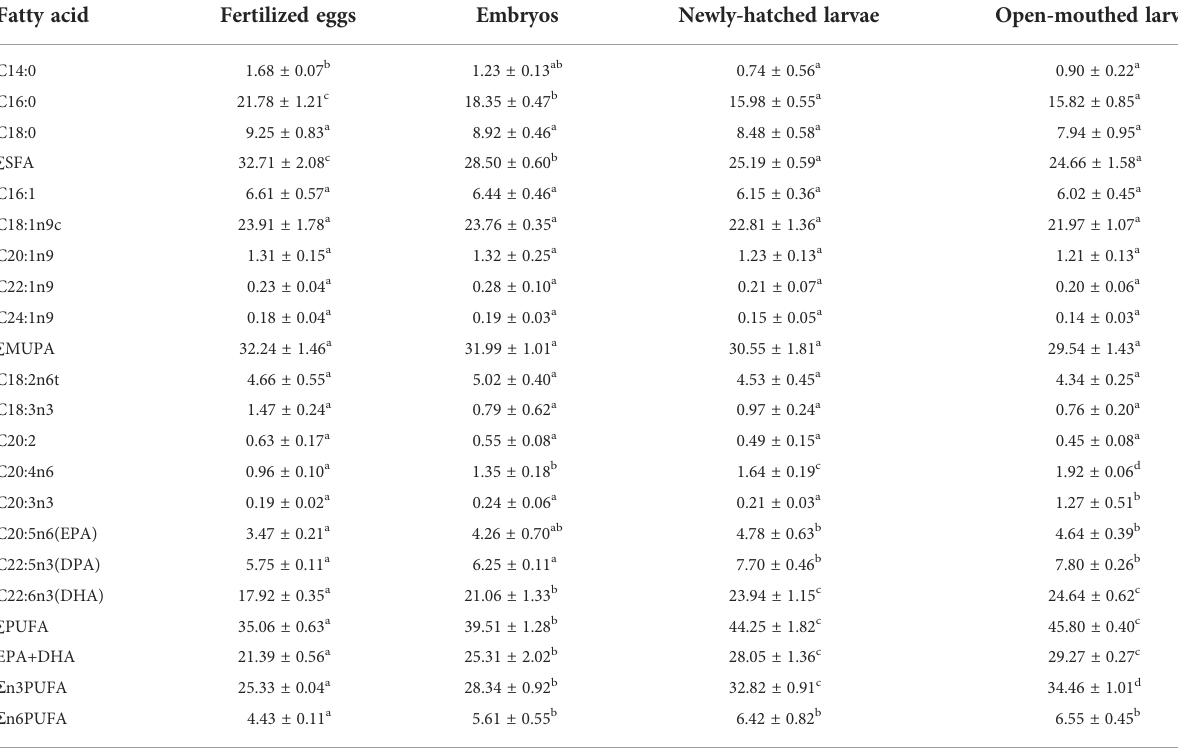
TABLE 4 Fatty acid composition and content of cobia in different development stages n=3, %. Fertilized eggs Embryos Newly-hatched larvae